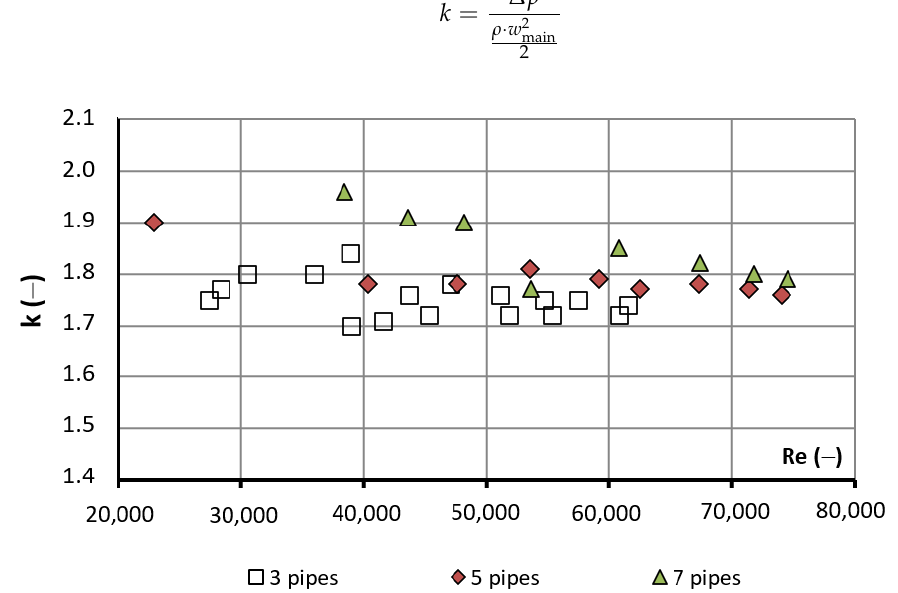
Figure 8. Total pressure loss coefficient vs. Reynolds number—results of experimental investigations.